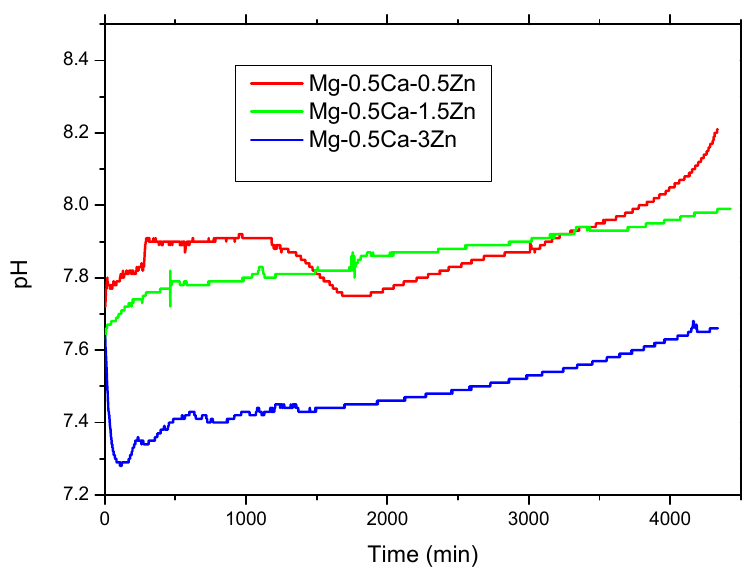
Figure 5. SBF solution pH variation after contact with the MgCaZn samples.